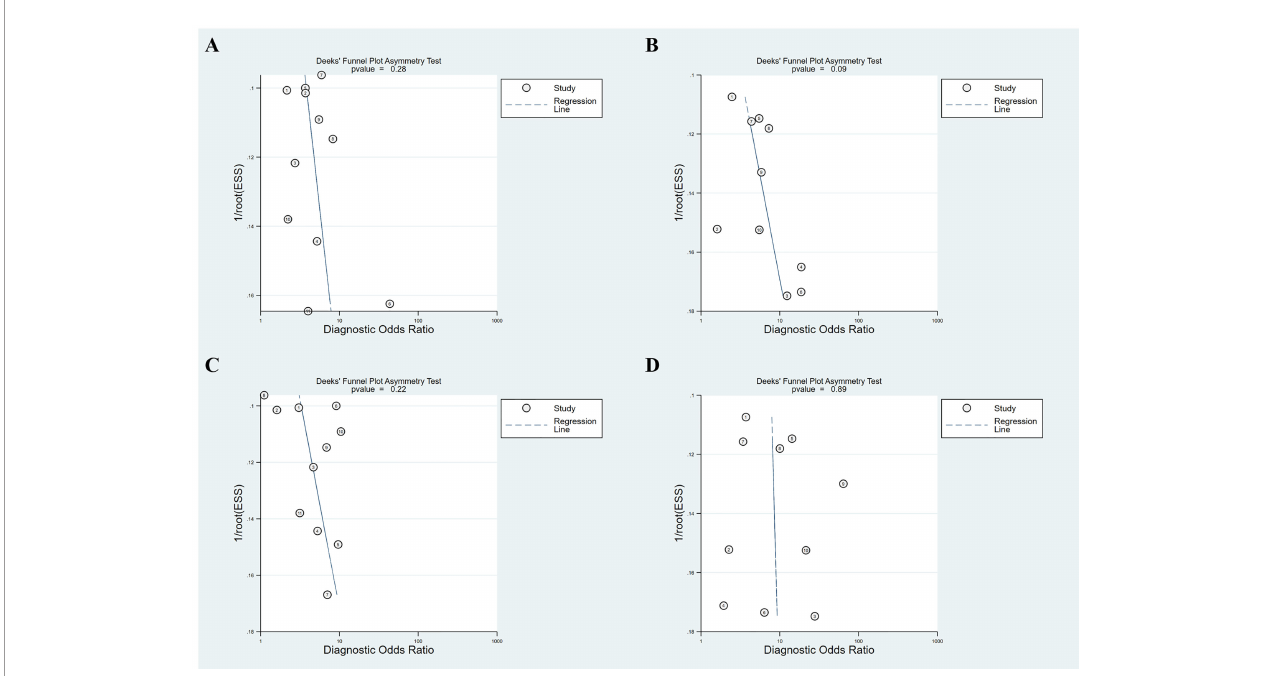
FIGURE 5 | Deeks ’ funnel plot asymmetry test for publication bias. (A) APRI for detecting advanced fi brosis; (B) APRI for detecting cirrhosis; (C) FIB-4 for detecting advanced fi brosis; (D) FIB-4 for detecting